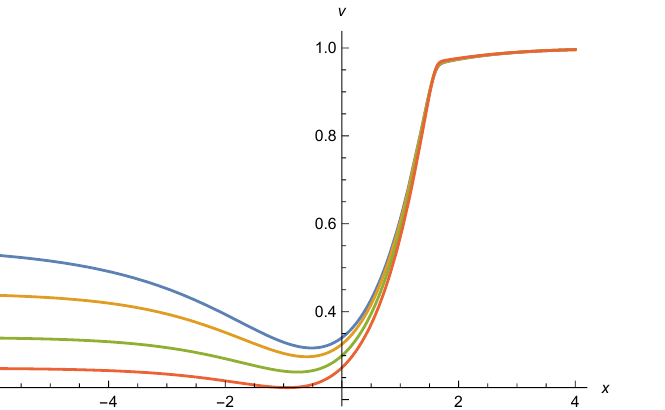
Figure 11. Ratio v = u / w as function of x = ln ( ˜ ρ ) for ξ = 0.1. Other parameters are as in Figure 10, with w 0 between 0.038 and 0.06 from top to bottom. One observes the common approach to the asymptotic value v = 1 for x → ∞ .